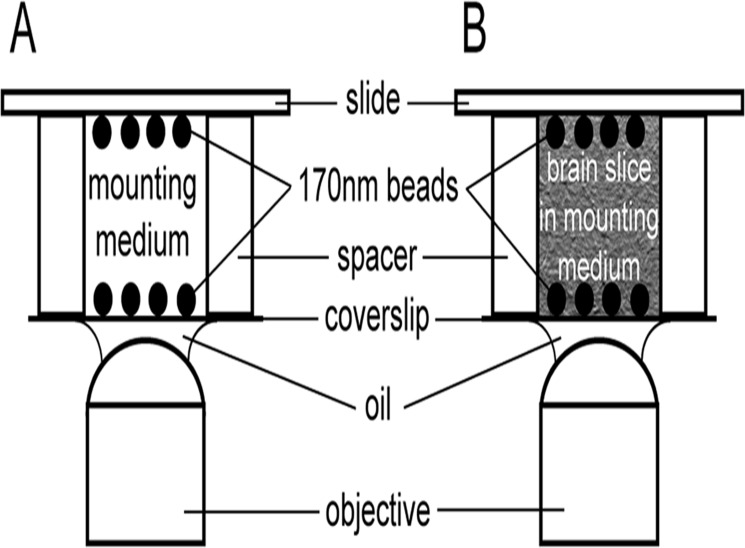
Experimental setup for evaluating axial resolution at different focusing depth with sub-resolution beads.(A, B) 170 nm green or red fluorescent beads have been immobilised on the coverslip and slide surface prior to mounting. One or two spacers of scotch tape (58 μm thick) have been introduced to obtain different depths. Coverslips have been assembled with mounting medium (A) or with brain slices incubated in mounting medium (B) and imaged with a 63x, 1.4 NA objective at 488 nm or 561 nm respectively.